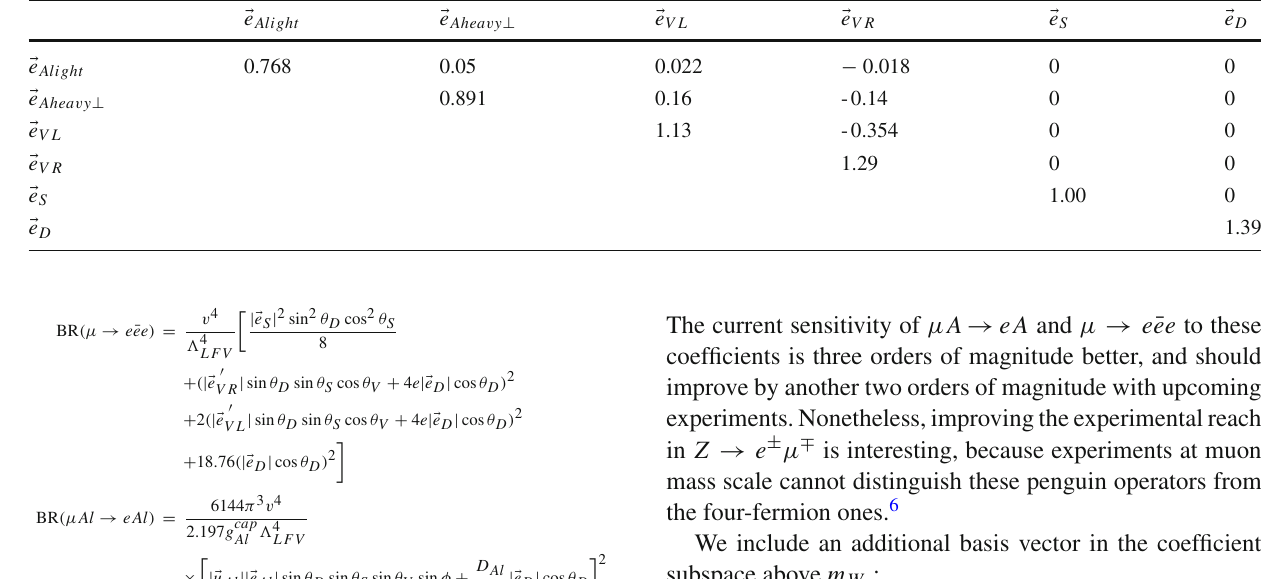
where η is the angle between the vectors. Overlaps smaller than 10 − 3 are given as